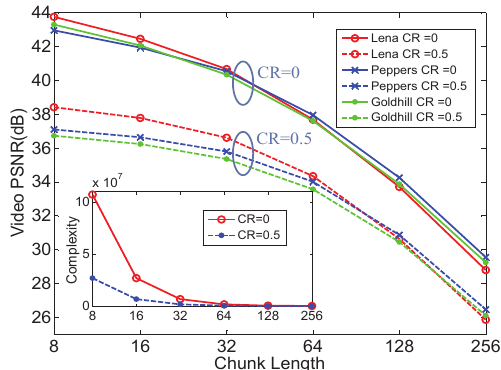
Figure 3: Performance evaluation for different chunk sizes.